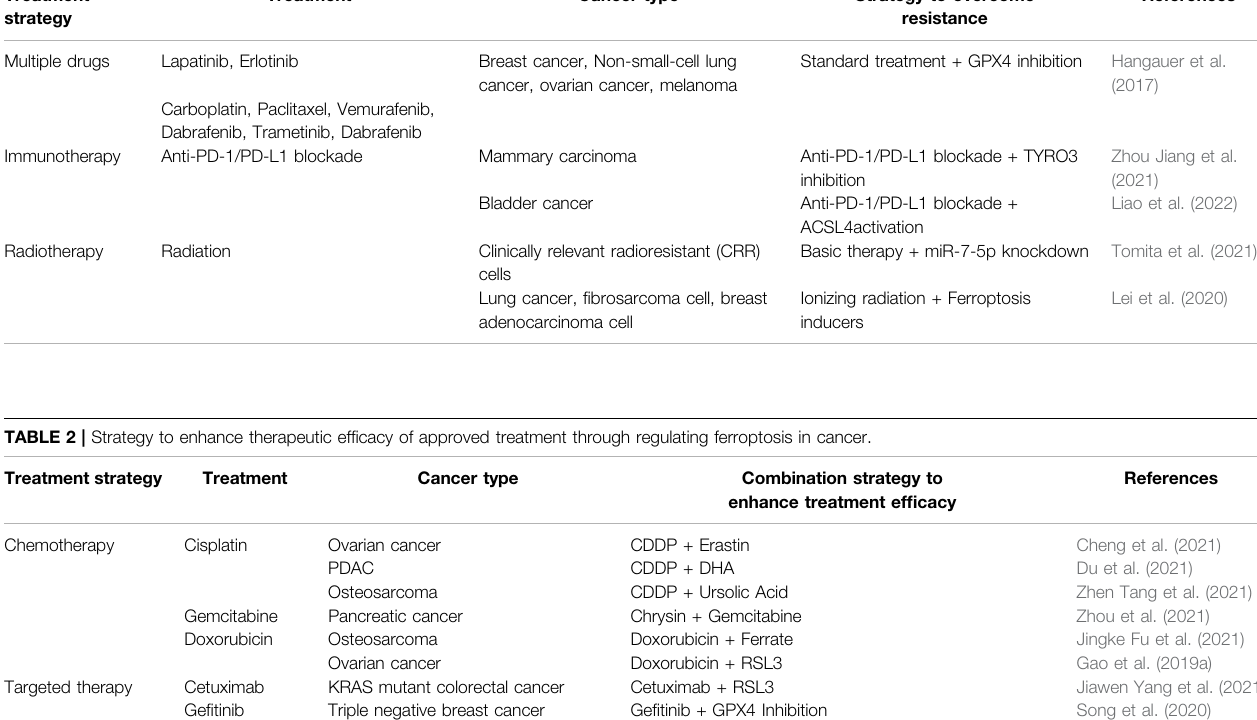
TABLE 1 | ( Continued ) Role of ferroptosis in drug resistance and the strategy to overcome treatment resistance in cancer. Treatment strategy